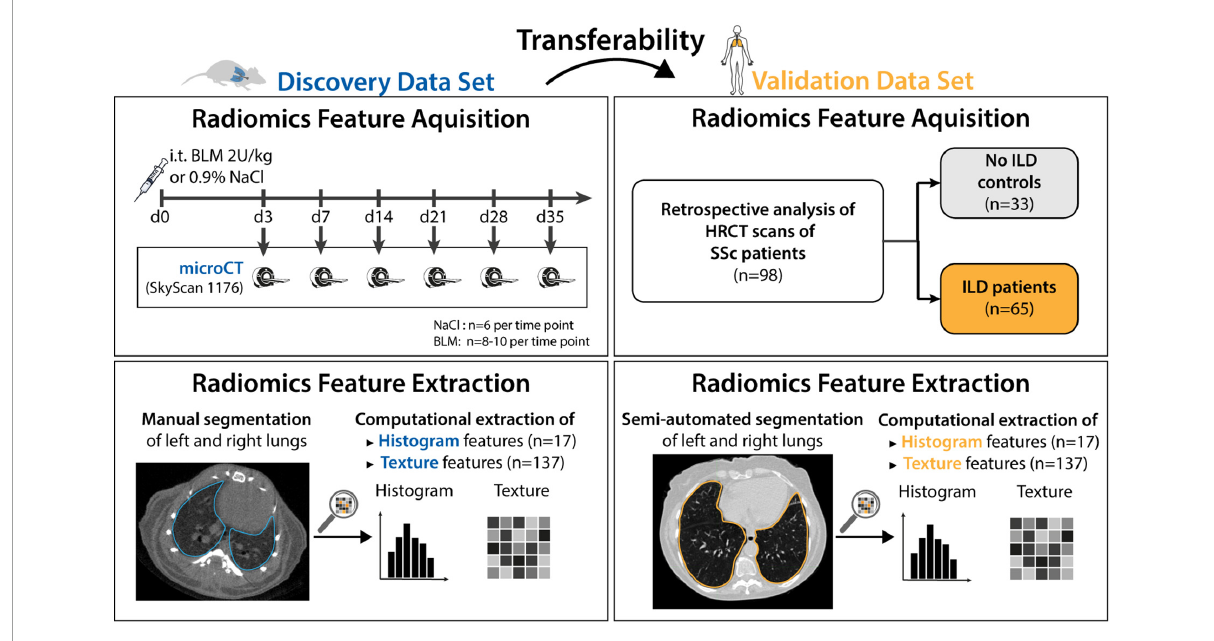
FIGURE1 Study design. The mice data set ( n = 91) was used to discover radiomic patterns predictive of ILD. The discovered patterns were tested in the human validation data set ( n = 98). 55 mice were given Bleomycin to induce ILD, whereas 36 mice were given NaCl and served as the control group. The mice were euthanized at day 3, 7, 14, 21, 28, and 35 and scanned with a microCT scanner. Afterward, classification models were trained to predict occurrence of ILD based on images acquired from the scanner. The 98 patients from the validation data set were retrospectively collected. All patients were scanned with HRCT and graded according to the Goh scale of pulmonary fibrosis. The radiomic models built using mice data were tested in